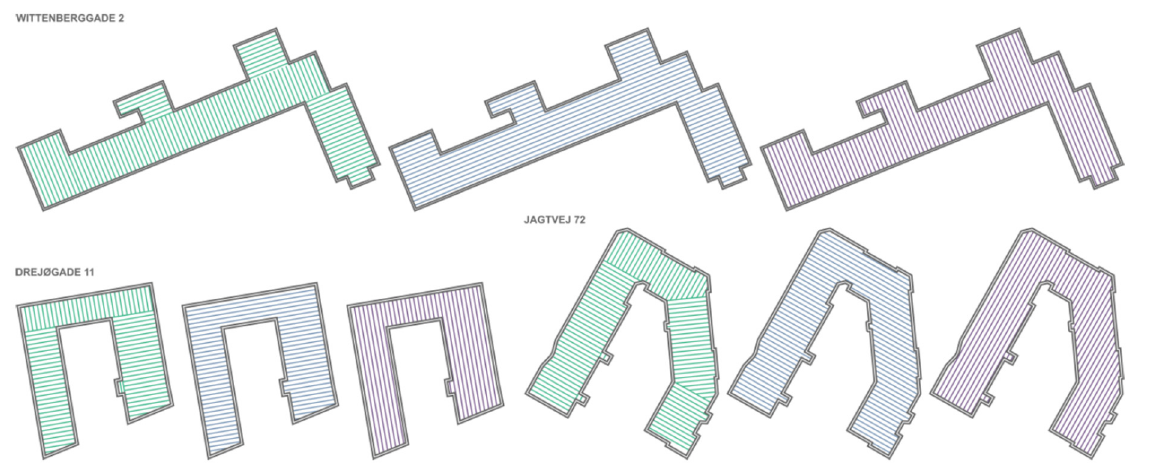
Figure 3. Beam span algorithm test, here showing three buildings actual span (green) and two different implementations tested (blue and purple).